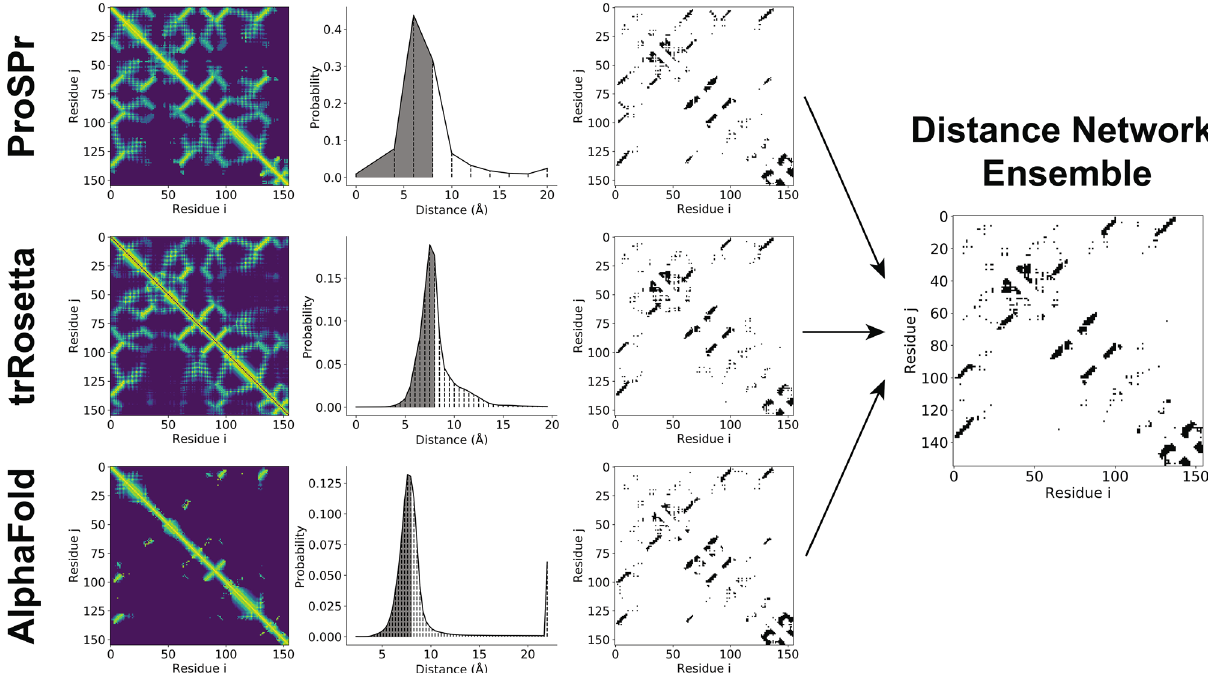
Figure 1. Schematic of method for deriving contacts from pairwise amino acid residue distance predictions and creating an ensemble, showing CASP13 domain T0986s2 as an example. The first column shows a flattened representation of the predictions from each of the three networks (ProSPr, trRosetta, and AlphaFold) where the brightness of each pixel represents how close the pair is most likely to be. The middle column shows an example of the full distance distribution for a specific amino acid pair (i = 130, j = 9) with vertical dashed lines showing the bin divisions used by each model (10, 36, and 64 bins respectively), and the shading representing the total probability to be in contact (distance ≤ 8 Å). Finally, the third column shows the most likely L contacts for each of the three ranges predicted by each network and provides comparison to the set of contacts predicted by ensembling the three